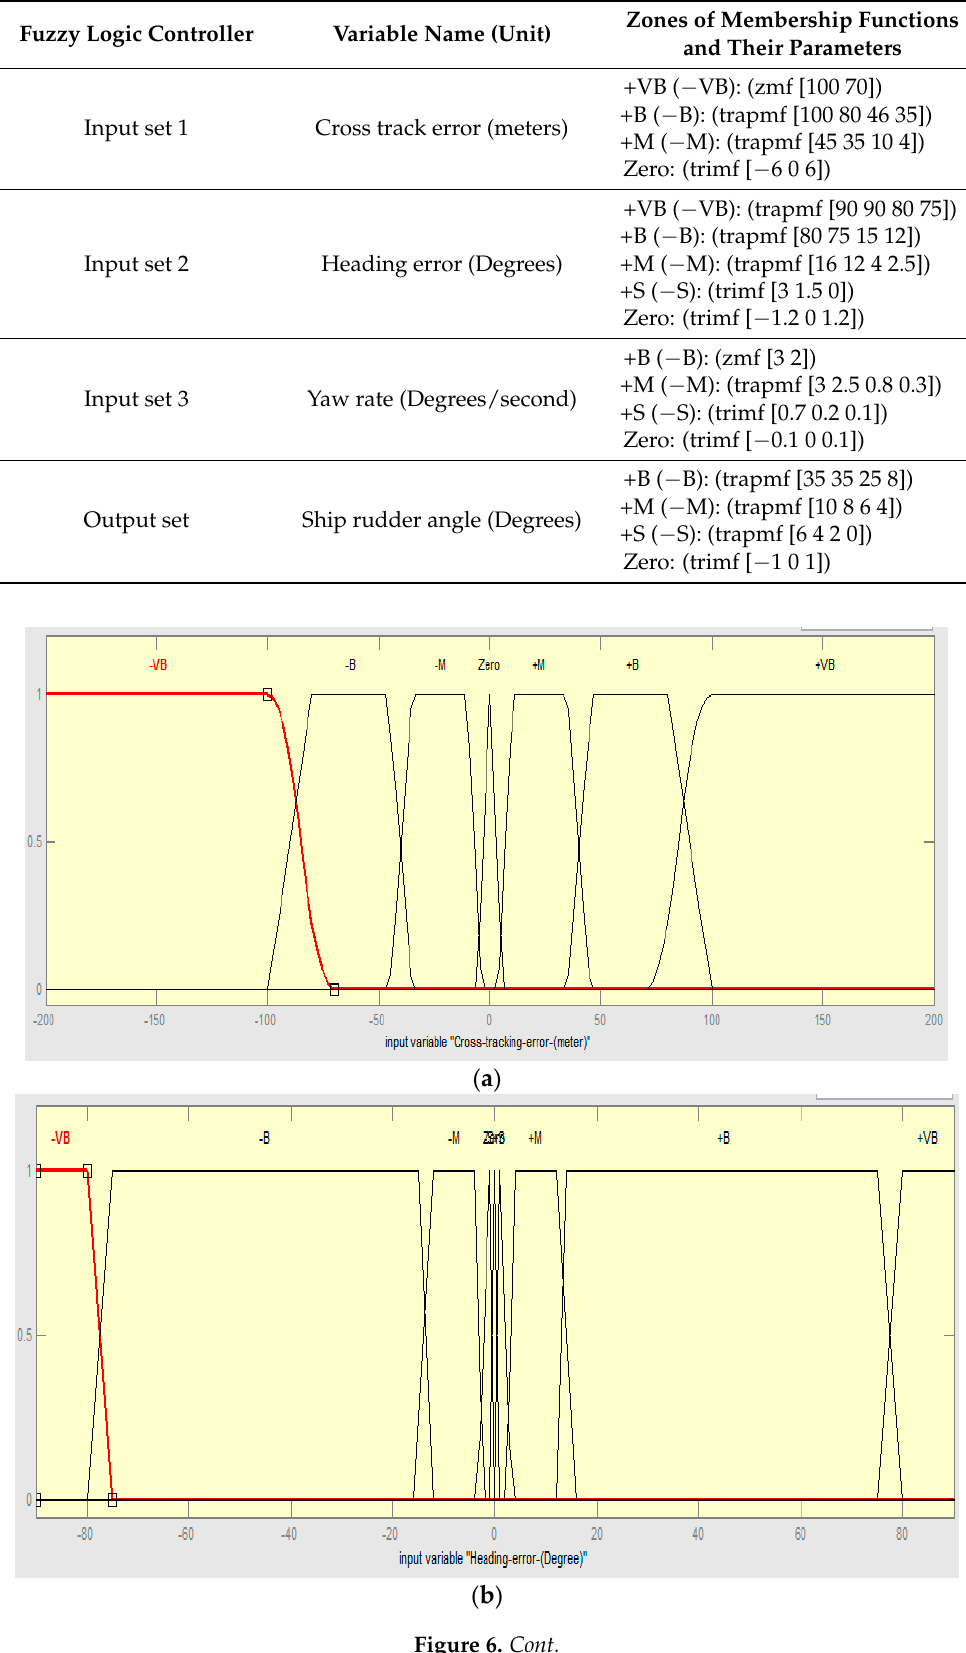
Table 3. The parameters of track-keeping controller.